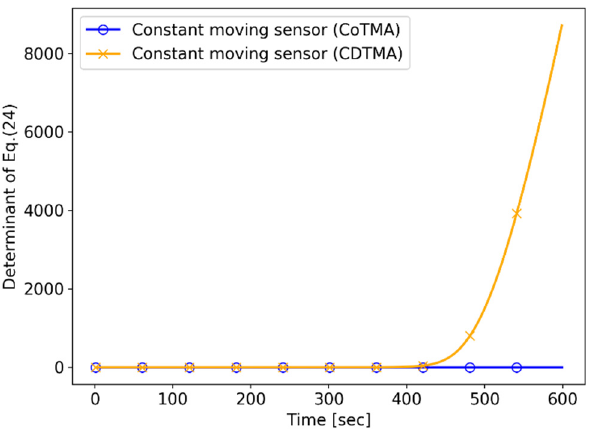
Figure 14. Simulation II: performance index (constant moving sensor scenario).